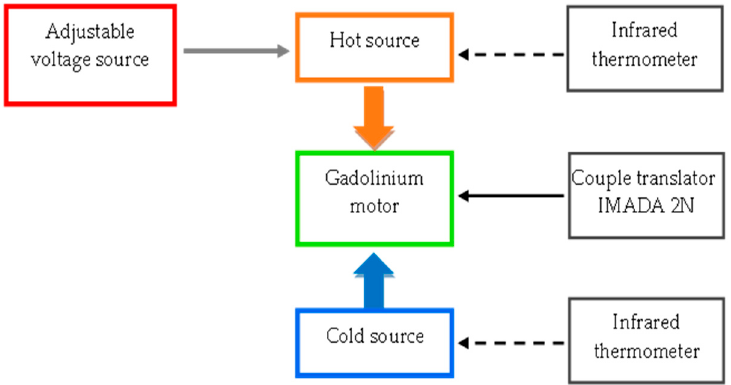
Figure 5. Block diagram for operation of the experimental stand.